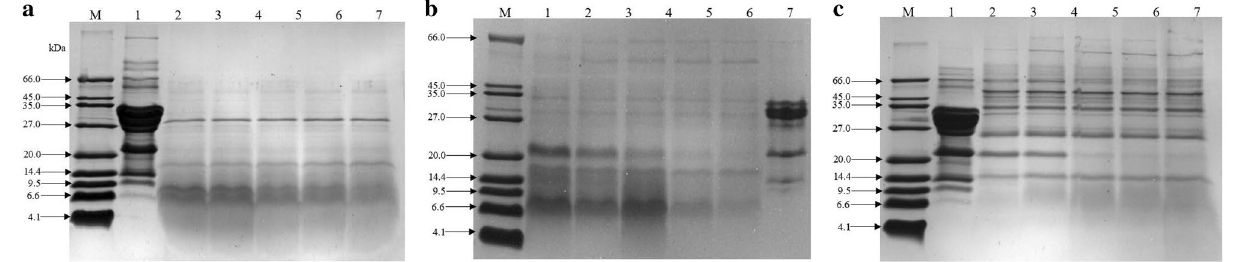
Figure 3. SDS-PAGE of CM with different enzymatic hydrolysis time. SDS-PAGE analysis. ( a – c ) represents Alcalase-treated cow milk (AT), Protamex-treated cow milk (PT), Flavourzyme-treated cow milk (FT), respectively. ( a , c ) Lane 1: marker; lane 2: CM; lane 3: 15 min; lane 4: 30 min; lane 5: 60 min; lane 6: 90 min; lane 7: 120 min; ( b ) Lane 1: marker; lane 2: 15 min; lane 3: 30 min; lane 4: 60 min; lane 5: 90 min; lane 6: 120